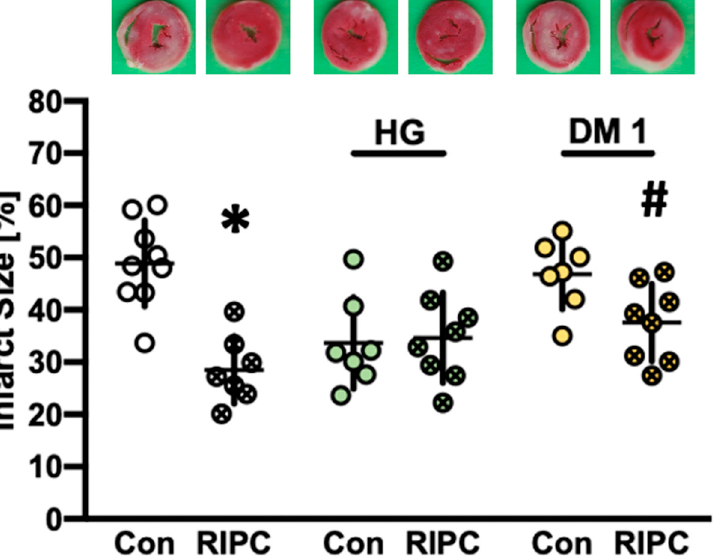
Figure 1. Infarct size measurement of part 1, including representative photos of each group. Con = control; RIPC = remote ischemic preconditioning; HG = hyperglycemia; DM1 = diabetes